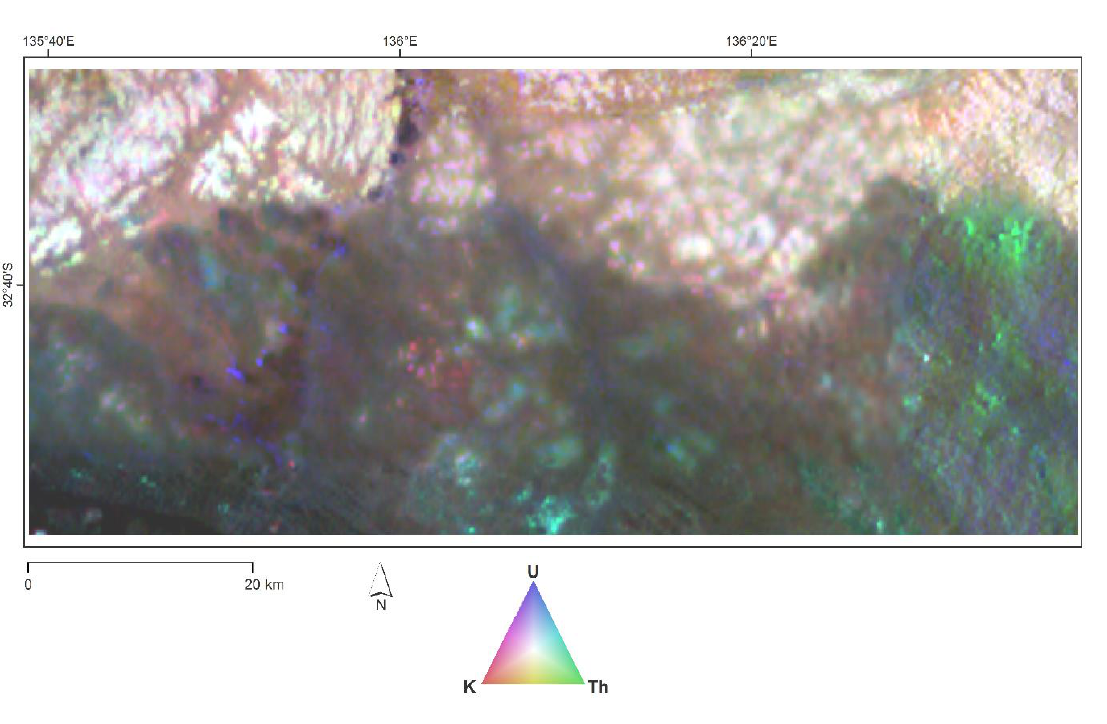
Figure 7. Ternary composite gamma ray radiometric map of the study area, sourced from SARIG.